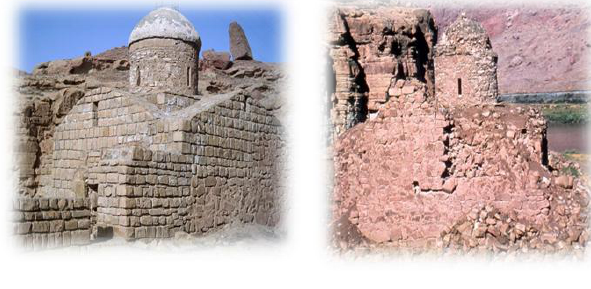
Figure 12. Previous